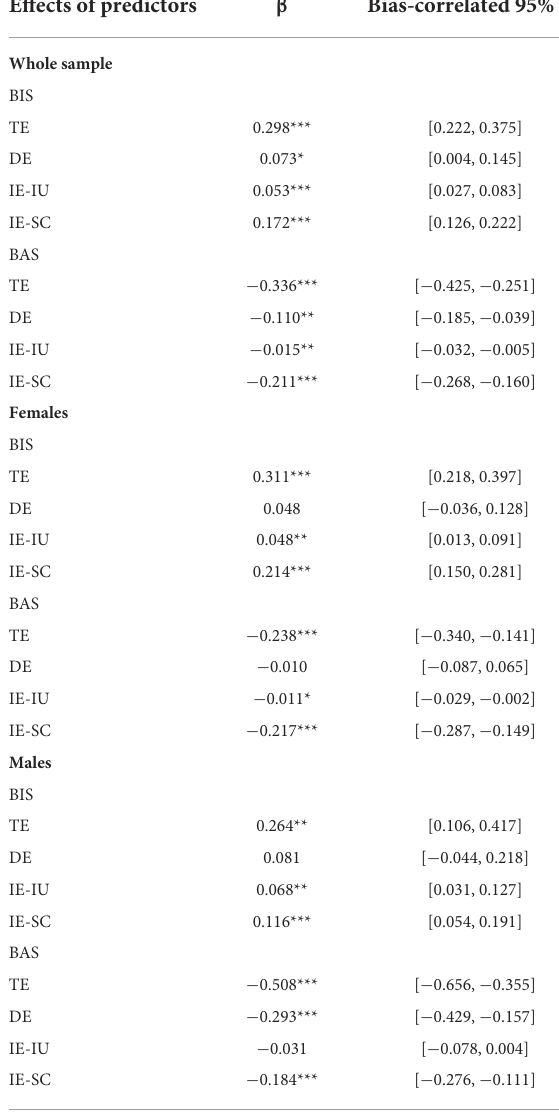
TABLE 3 Total, direct, and indirect effects of BIS/BAS on Internet addiction. Effects of predictors